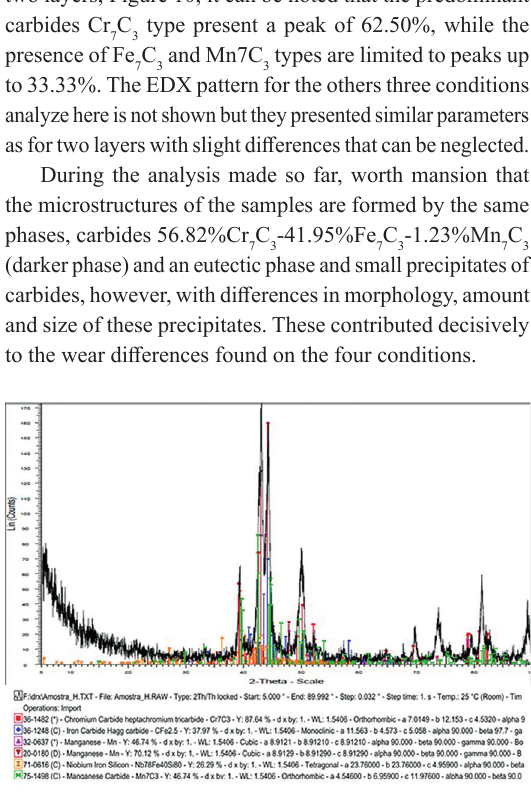
Figure 10: EDX of the welded sample containing two deposited layers (coating surface).